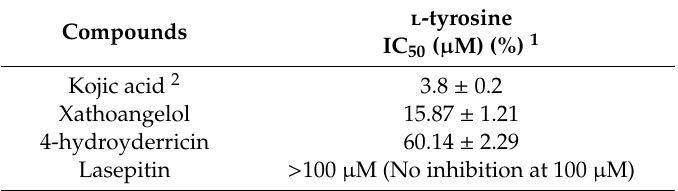
Table 3. Effect of kojic acid, 4-hydroderricin, xanthoangelol and laserpitin on mushroom tyrosinase